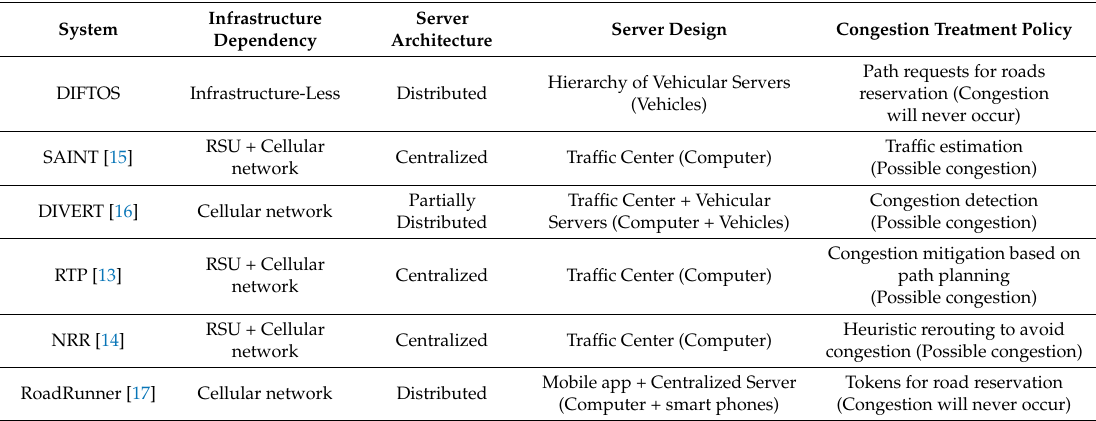
Table 1. Comparison between DIFTOS and state-of-the-art